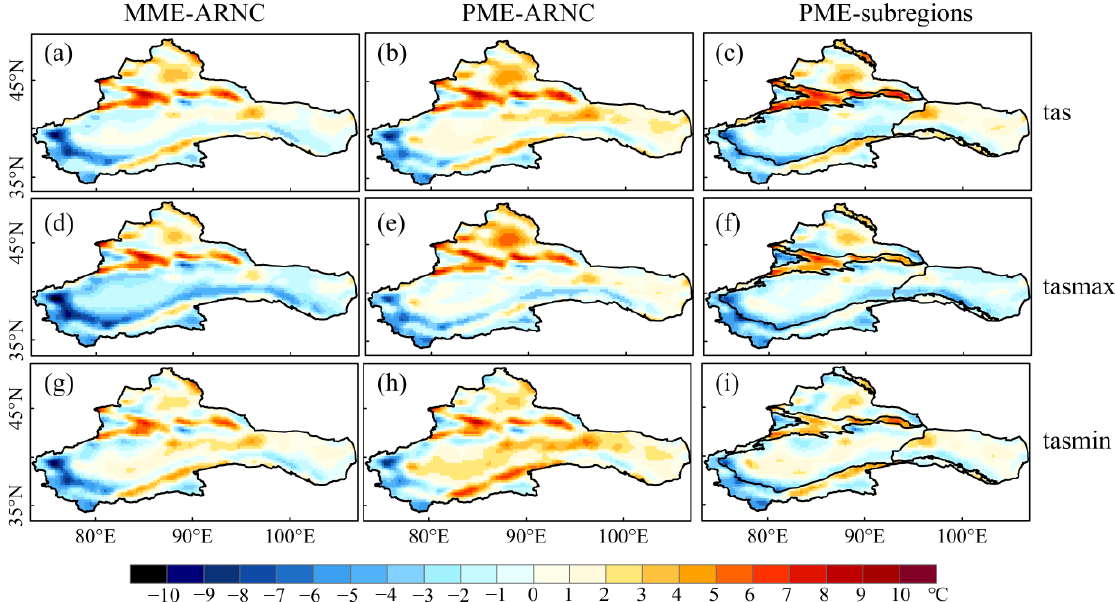
Figure 7. Bias field (simulation field minus observation field) of mean temperature under MME ( a , d , g ), PME ( b , e , h ) and PME of subregions ( c , f , i ) during 1961 – 2014. Upper row, tas; middle row, tasmax; bottom row, tasmin.